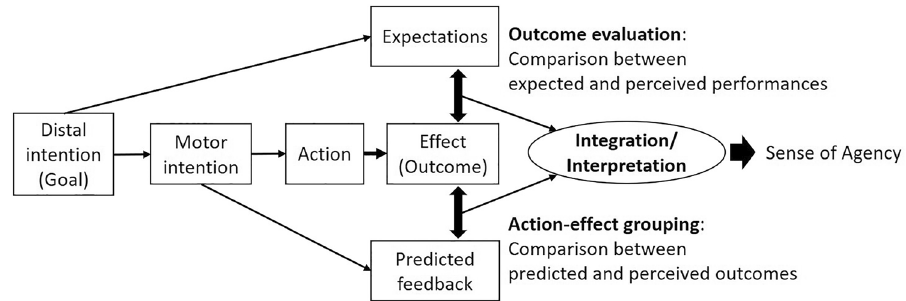
Figure 3. A simplified conceptual model of the sense of agency. Wen et al. 36 described a more detailed model of the sense of agency. In this model, distal intentions produce performance expectations, and motor intentions produce predictions about feedback, which the model integrates by comparing them with actual action outcomes, thereby generating the